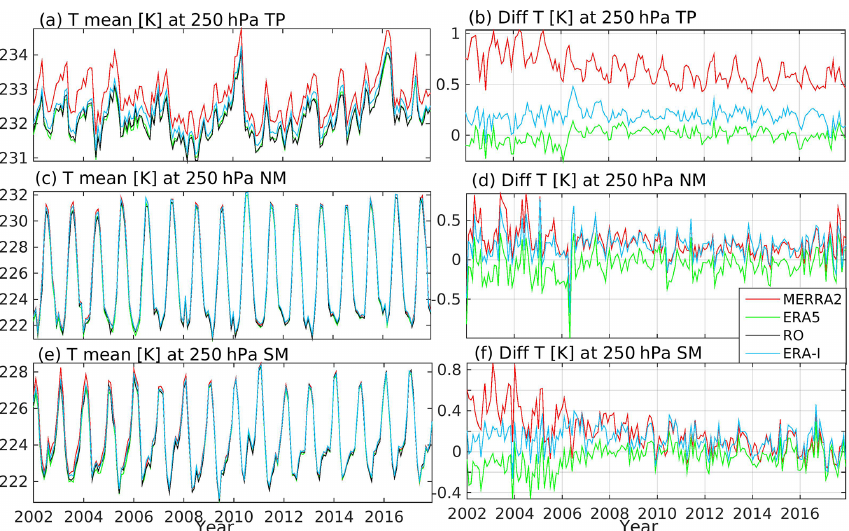
Figure 1. Monthly mean temperature in K at 250hPa through the three latitude bands of the tropics (TP) (10 ◦ S–10 ◦ N) (a) , northern midlatitudes (NM) (25–45 ◦ N) (c) , and southern midlatitudes (SM) (25–45 ◦ S) (e) . Corresponding differences between three reanalyses and the GNSS RO in panels (b) , (d) and (f) . Models with 103 levels (margin), ERA5 (green), ERA-I (light blue), MERRA2 (red) and GNSS RO (black) are